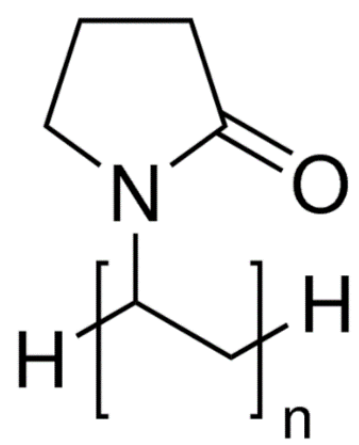
Figure 6. Represents the chemical structure of HPMC